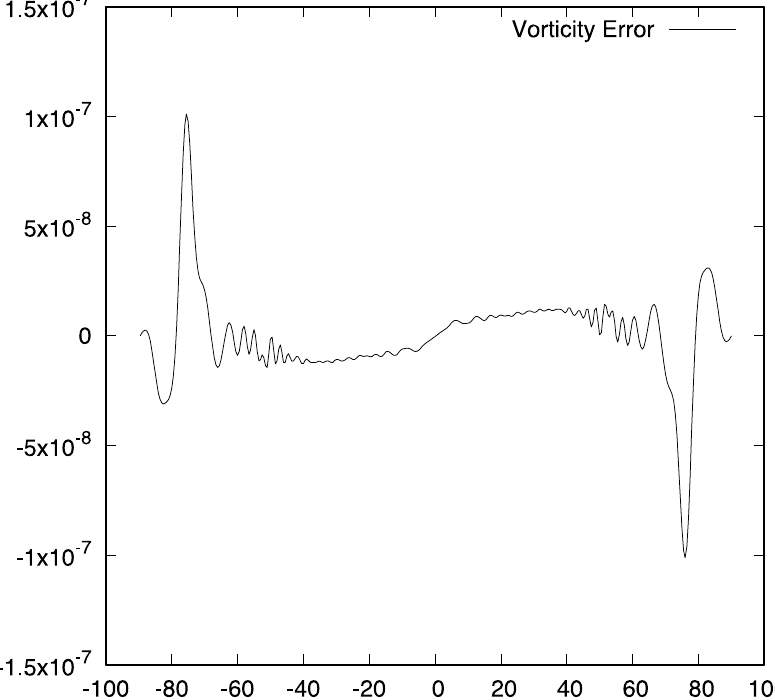
Figure 6. North–south cross-section of the vorticity errors at 40° longitude.